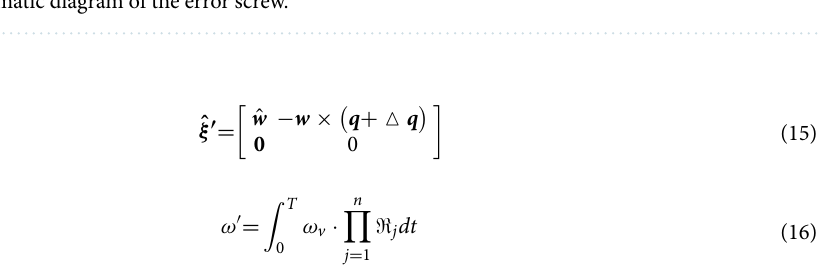
Figure 4. The schematic diagram of the error